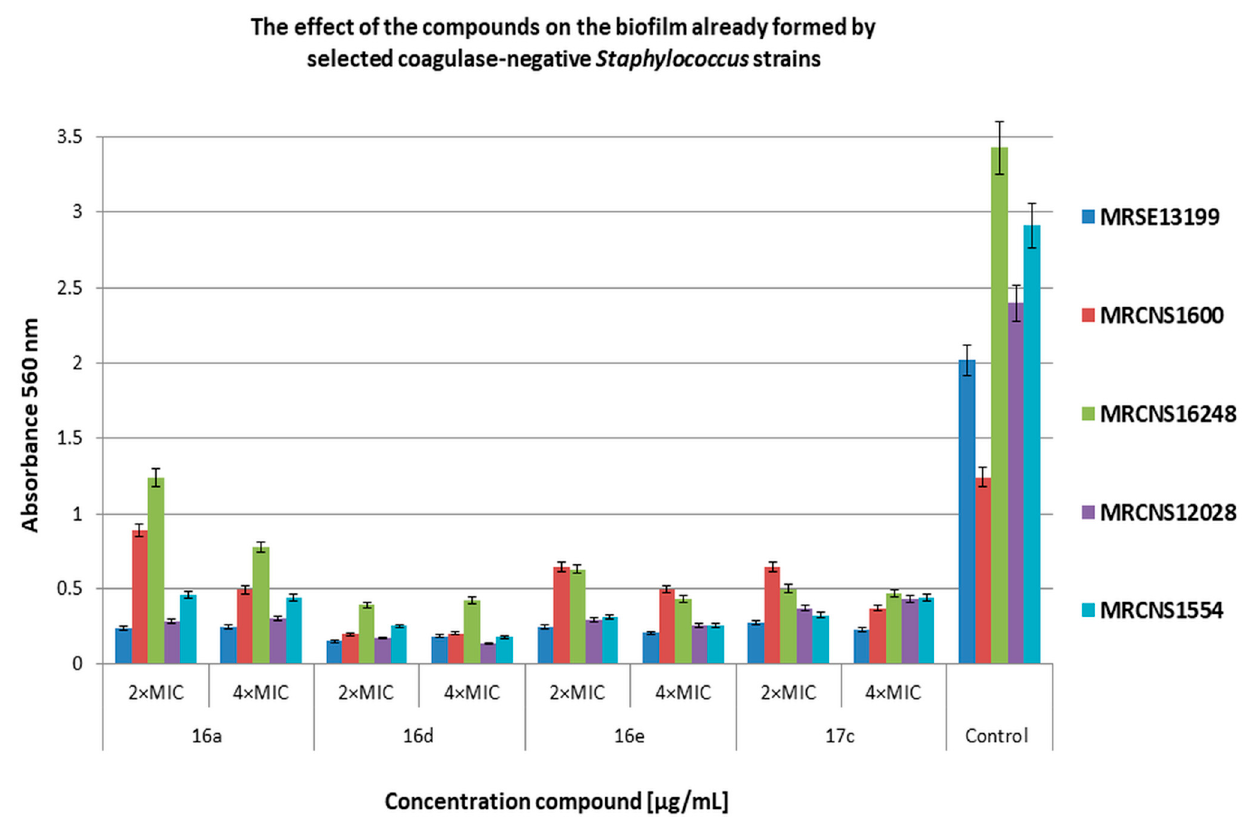
Figure 7. The effect of the selected compounds on 24 h biofilm already formed by the methicillin- resistant coagulase-negative Staphylococcus (MRCNS) strains. Bacteria without compounds were a control group. Double the minimum inhibitory concentration—2 × MIC, quadruple the minimum inhibitory concentration—4 × MIC. The results are presented as mean values ± standard deviation (±SD) from three independent experiments. Error bars represent standard deviation.